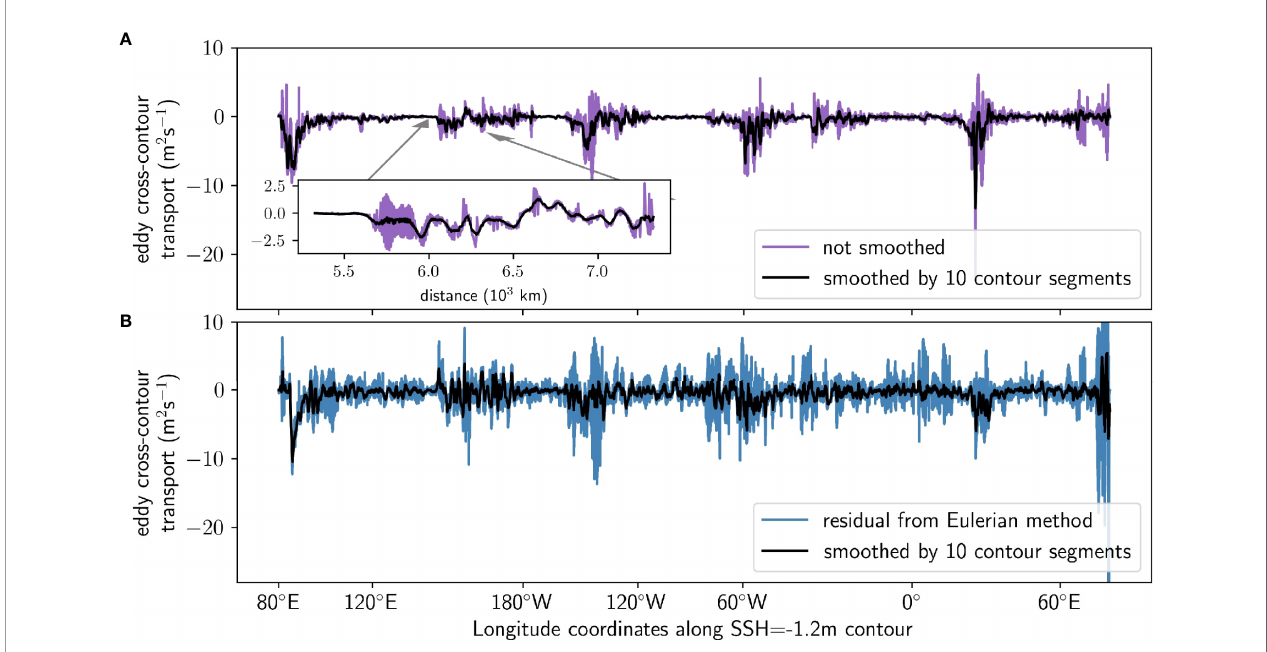
FIGURE 5 | (A) Cross-contour eddy transport t eddy , calculated according to Eqn. (10) across the -1.2m SSH contour summed over the density range 1032.2 < s 1 < 1032.5 kg m -3 , for unsmoothed (colours) and smoothed (black, running average over 10 contour segments) cases. (B) as for panel A, but with the eddy transport calculated using the traditional method as the difference between the residual overturning in s 1 coordinates, and the Eulerian mean (i.e. depth space) overturning mapped to s 1